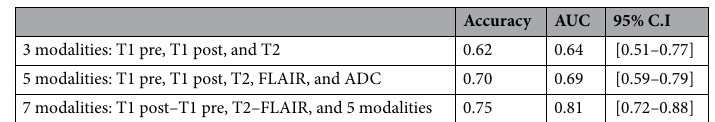
Table 2. Classification mean accuracy, AUC, and 95% C.I. for CNN-LSTM models.